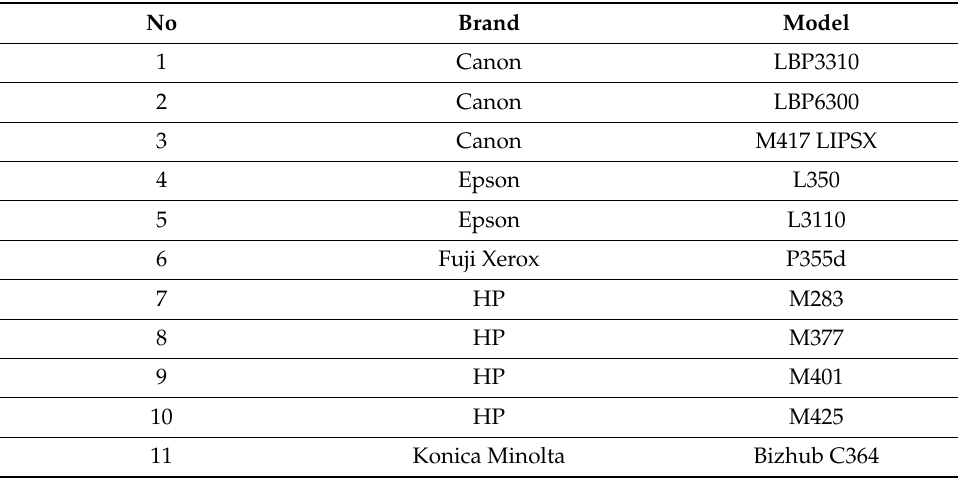
Table 1. Printer and Brand Model List (BW QR